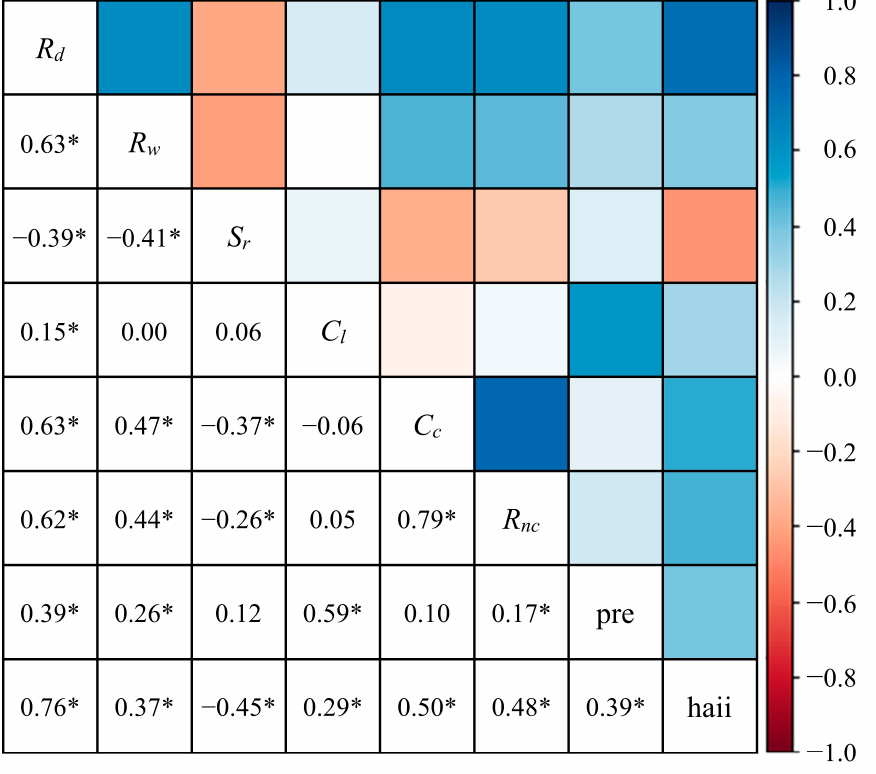
Figure 7. Plots illustrating the Pearson correlation coefficients among SCCs (i.e., R d , R w , S r , C l , C c , and R nc ), precipitation (pre) and human activity intensity index (haii). And * indicate p < 0.05.